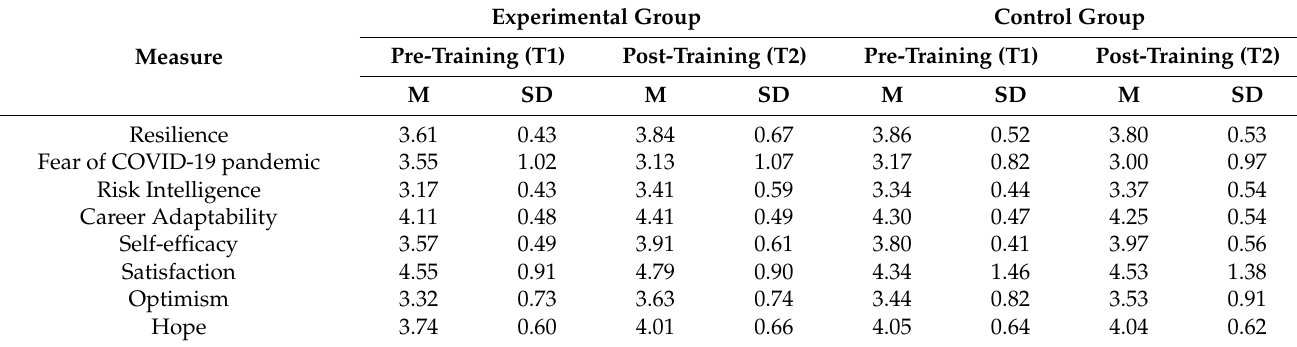
Table 2. Means and standard deviations of experimental and control groups at pre-test and